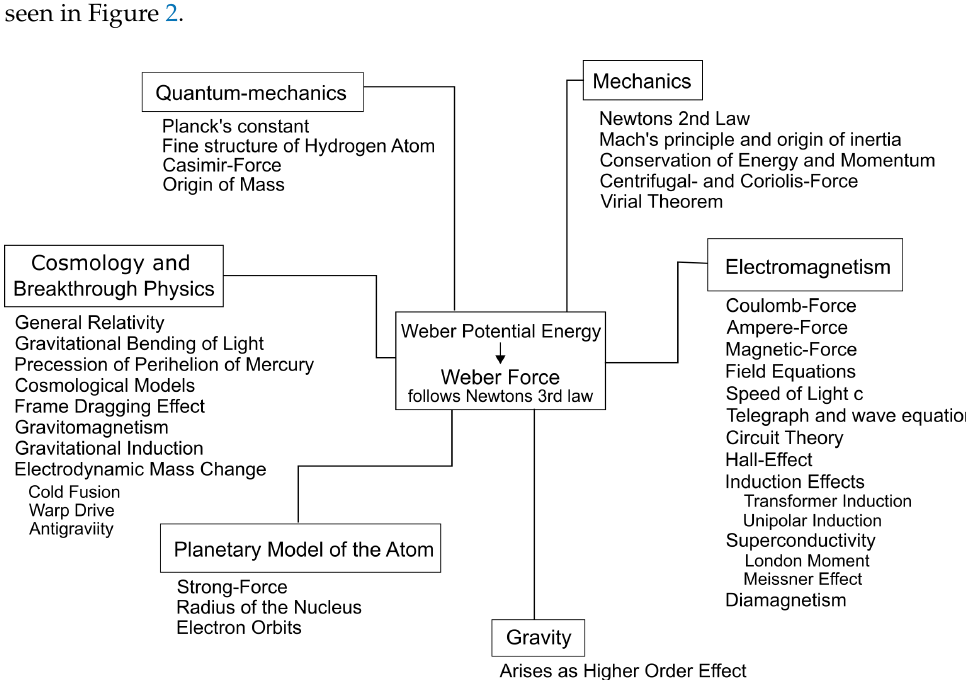
Figure 2. A visual map providing an overview of the different subsidiary fields and phenomena that Weber’s theory has been shown to provide a basis for and connects with throughout the branches of physics and